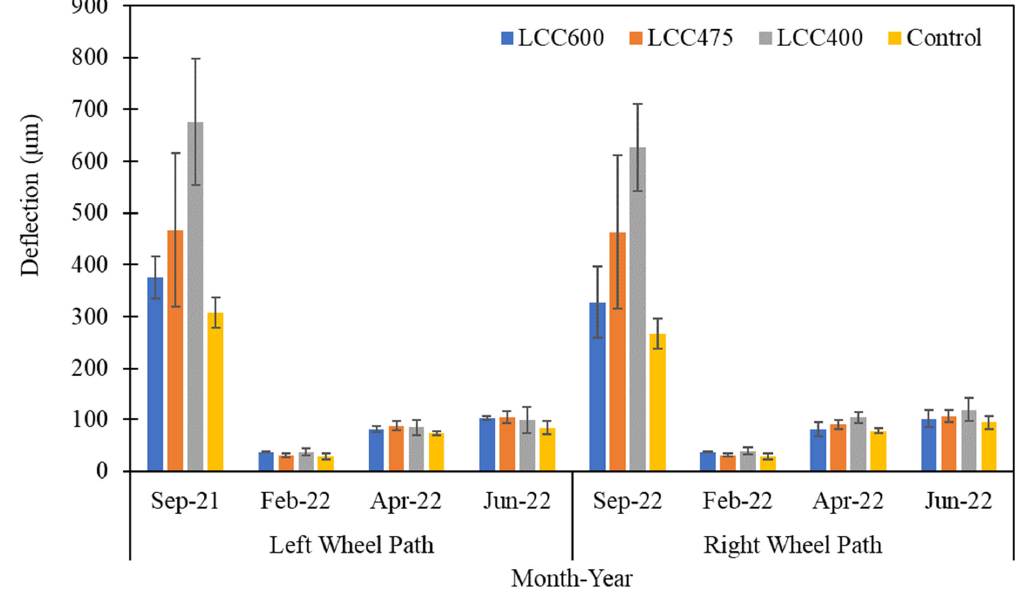
Figure 9. Notre Dame Drive southbound measured de fl ection.